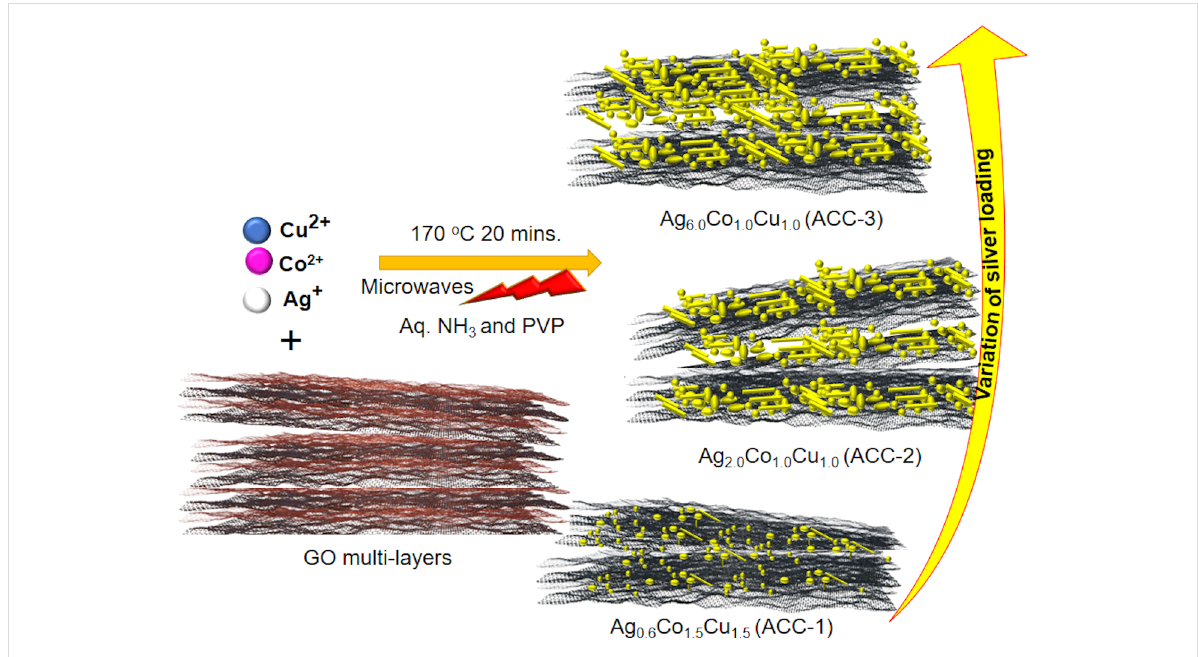
Figure 1: Illustration of the formation of AgCoCu oxide NPs over rGO with tuneable Ag fractions.